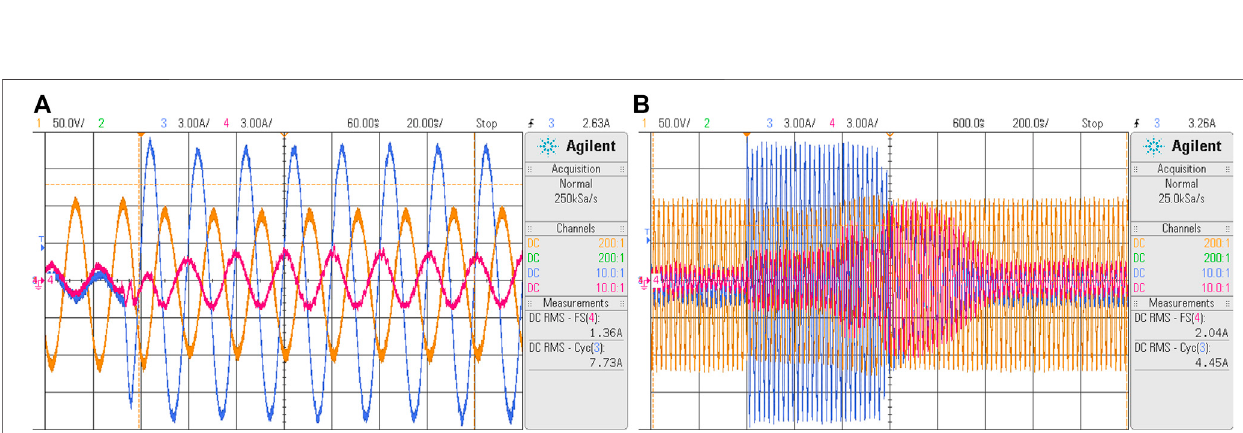
Frontiers in Energy Research |